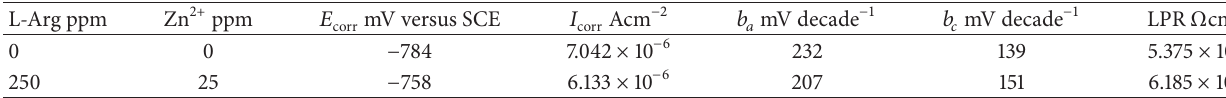
Table 5: Corrosion parameters of carbon steel immersed in sea water in the absence and presence of inhibitors obtained by polarization method.